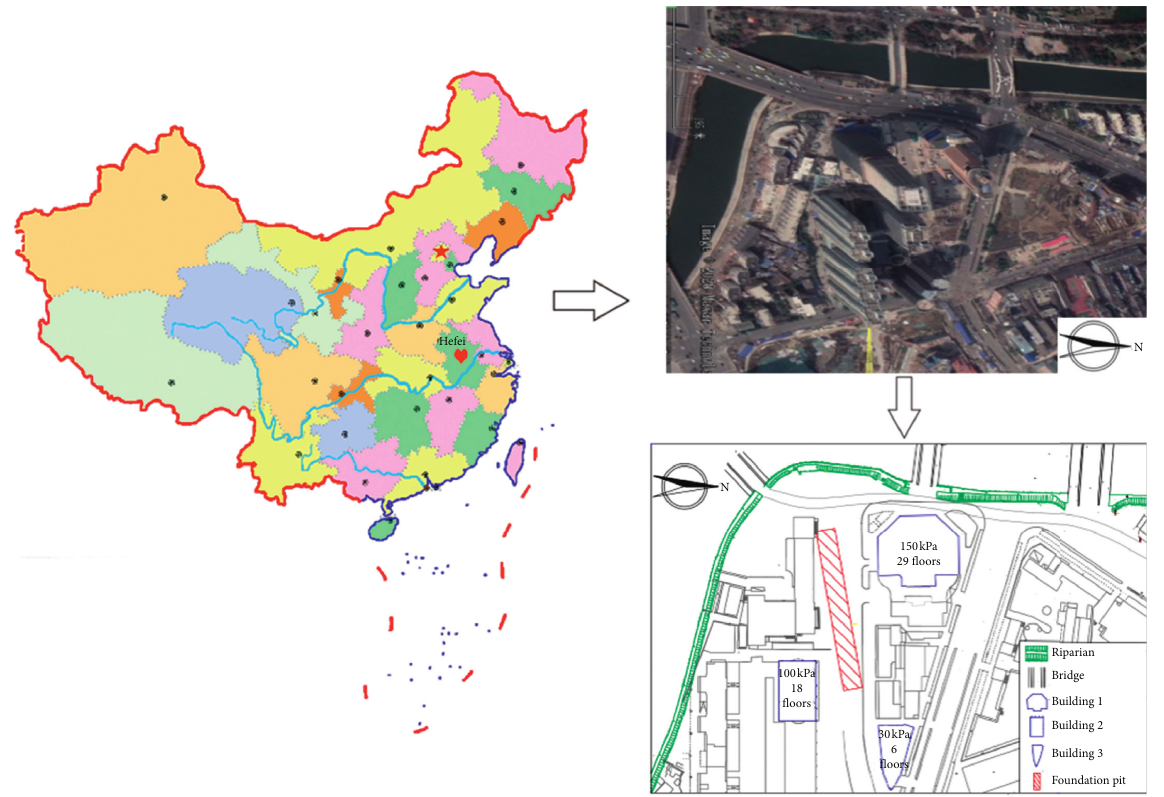
Figure 1: The location of the project site. Surface elevation (25.5m)